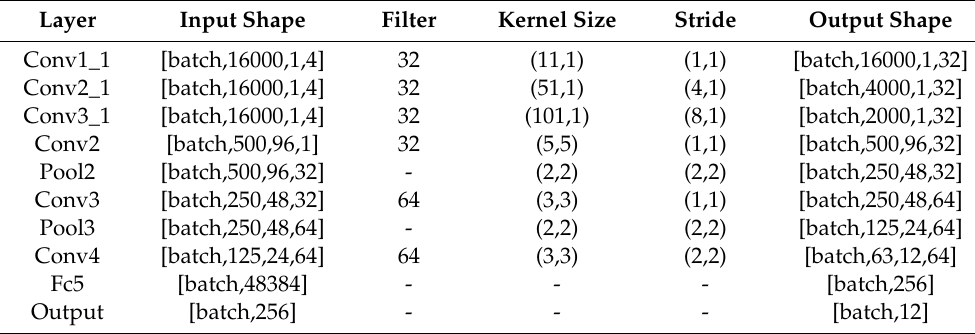
Table 1. Parameters of the attention-based multi-scale CNN